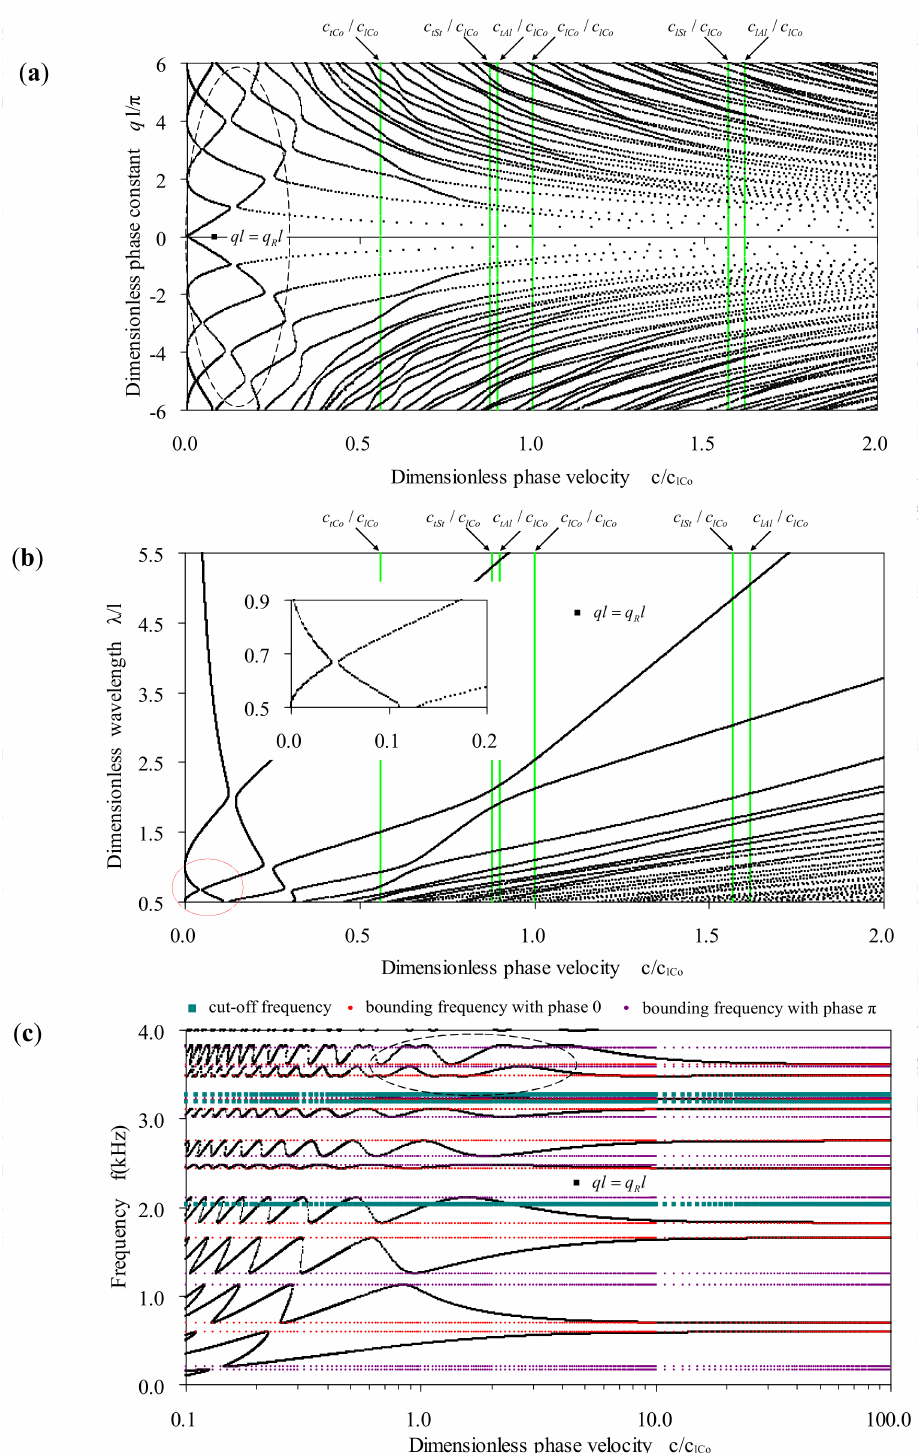
Figure 7. Phase velocity-related dispersion curves of bending waves in the bi-coupled periodic beam with Ternary-I unit cell: ( a ) the phase velocity-wavenumber curves; ( b ) the phase velocity-wavelength curves; ( c ) the phase velocity-frequency